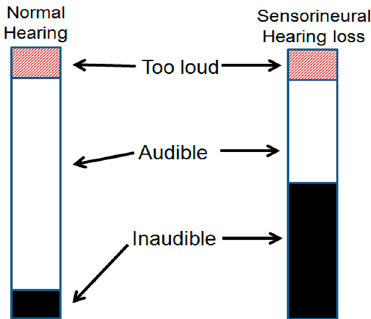
Figure 1. Hearing dynamic range: normal hearing vs. hearing